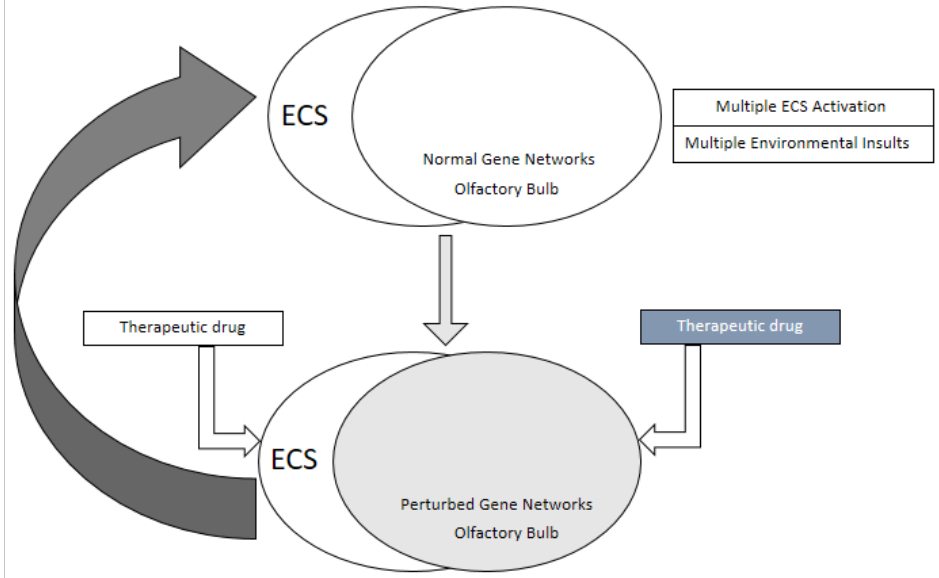
Figure 2. The endocannabinoid system (ECS) and the olfactory bulb as a site of therapeutic intervention for a functional olfactory pathway and neuronal homeostasis. ECS activation in response to diverse stimuli and environmental insults to the olfactory bulb affects overlapping physiological pathways and gene regulatory networks (top part of the figure) resulting in perturbed gene regulatory networks (shaded olfactory bulb in the lower half), a probable cause of onset and progression of olfactory deficits. The olfactory bulb and components of ECS can be used as therapeutic targets to restore homeostasis and physiological pathways as well as functional gene regulatory networks at a normal level. Just as there are multiple therapeutic targets, there could be at least two broader sets of therapeutic drugs: one set modulating ECS and the other set regulating olfactory bulb specific pathways at single cell level.